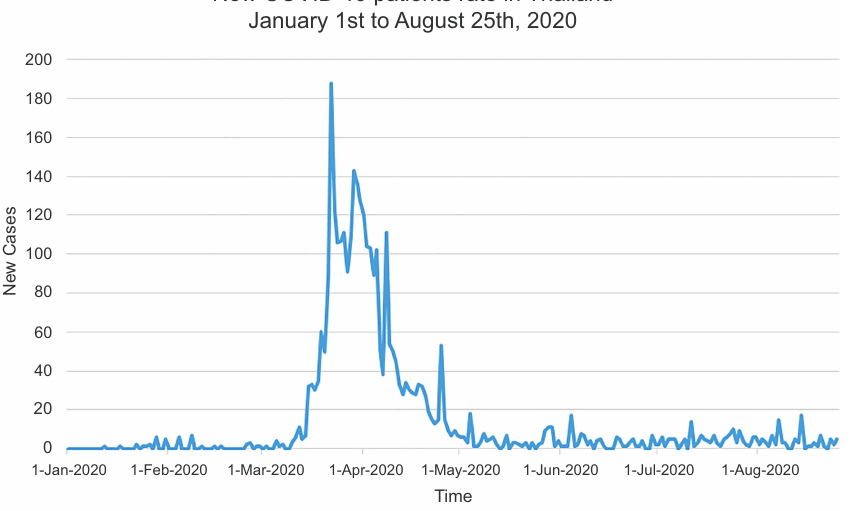
Figure 1. NewCovid-19patient ’